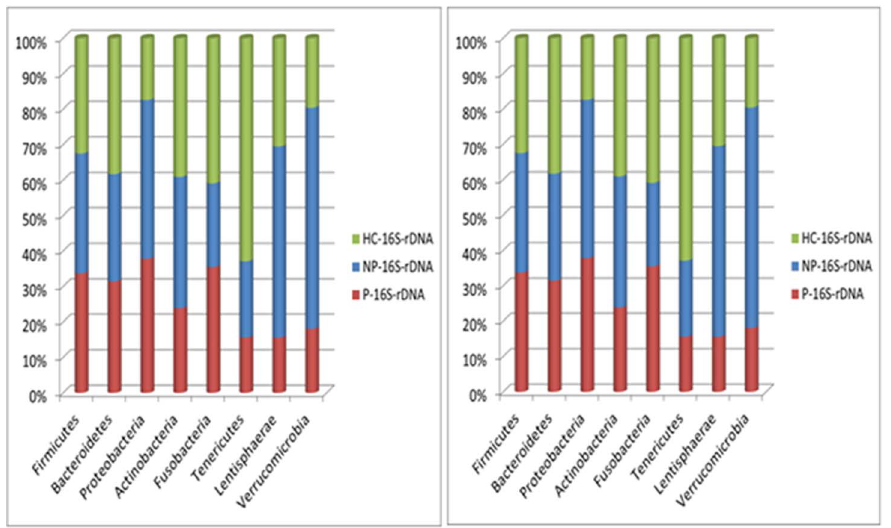
Figure 3. Comparison of total and active bacterial phyla found in feces of subjects. Bacterial phyla distribution (%) found in fecal samples of immunoglobulin A nephropathy (IgAN) non progressor (NP) and progressor (P) patients, and healthy controls (HC). The X-axis represents the proportion of phyla from total (16S rDNA) and active (16S rRNA) bacteria.